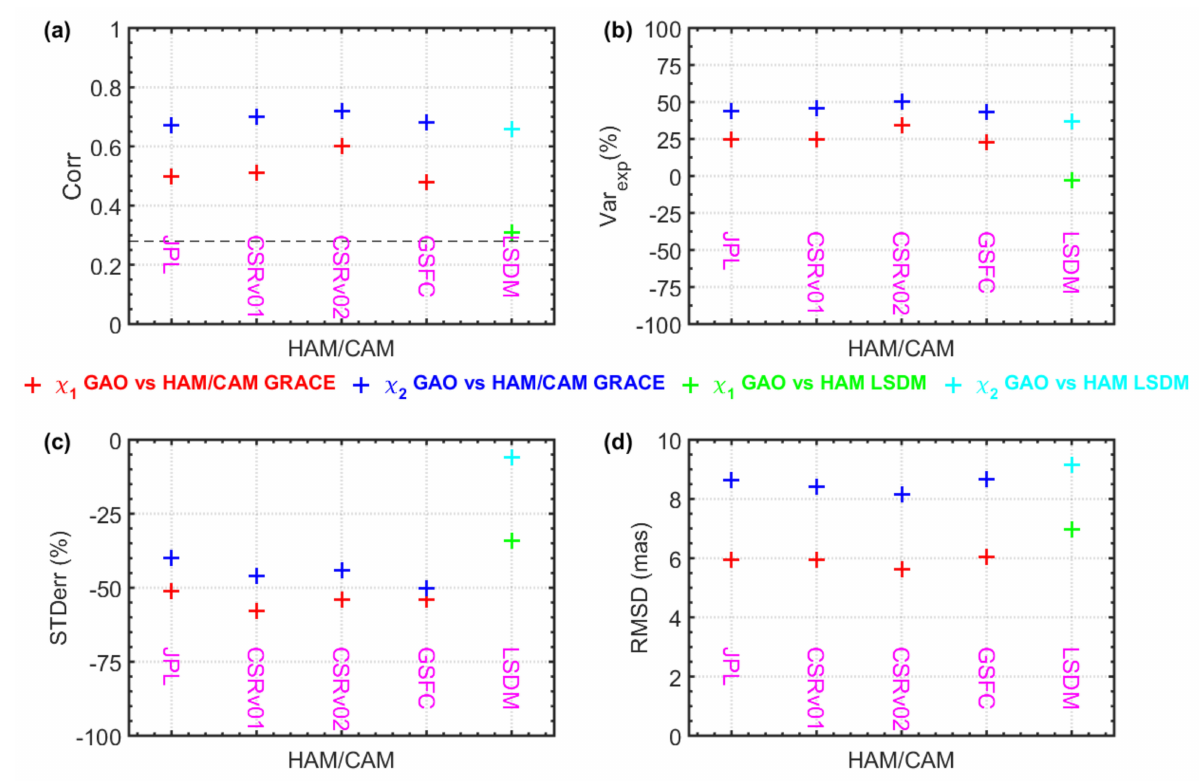
Figure 8. ( a ) Correlation coefficients (Corr) between HAM/CAM and GAO and between HAM and GAO, ( b ) percentage of variance in GAO explained by HAM/CAM and HAM (Var exp ), ( c ) error of STD (STDerr) of HAM/CAM and HAM, and ( d ) root mean square deviation (RMSD) of HAM/CAM and HAM. Non-seasonal variations are considered. Note that for non-seasonal variations, the critical value of the correlation coefficient for 36 independent points and a 95% confidence level is 0.28, while the standard error of the difference between the two correlation coefficients is